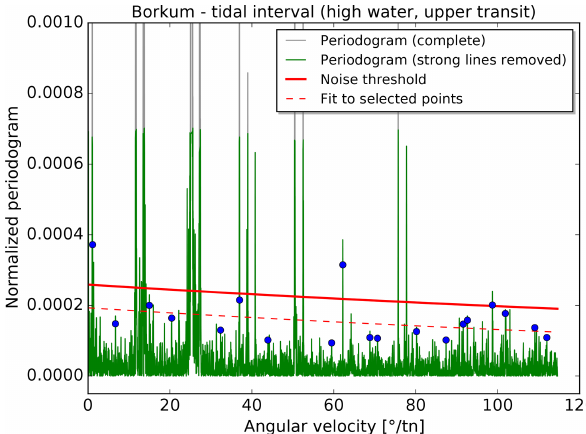
Figure 4. Determination of the noise threshold for the tidal interval (high water, upper transit) at tide gauge Borkum, Fischerbalje. The strongest lines are removed from the periodogram (grey vs. green lines; first step as described in Sect. 4.3) and an exponential function (dashed red curve) is fitted to selected points (blue; second step as described in Sect. 4.3). The noise threshold (thick red line) is shifted up by 1 standard